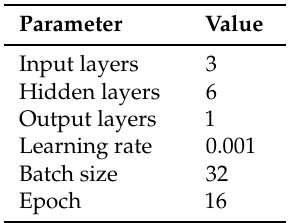
Table 2. Parameter setup for training the pairing